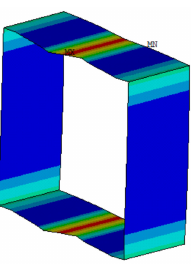
Figure 13. Stress cloud diagram of a section after applying residual stress.